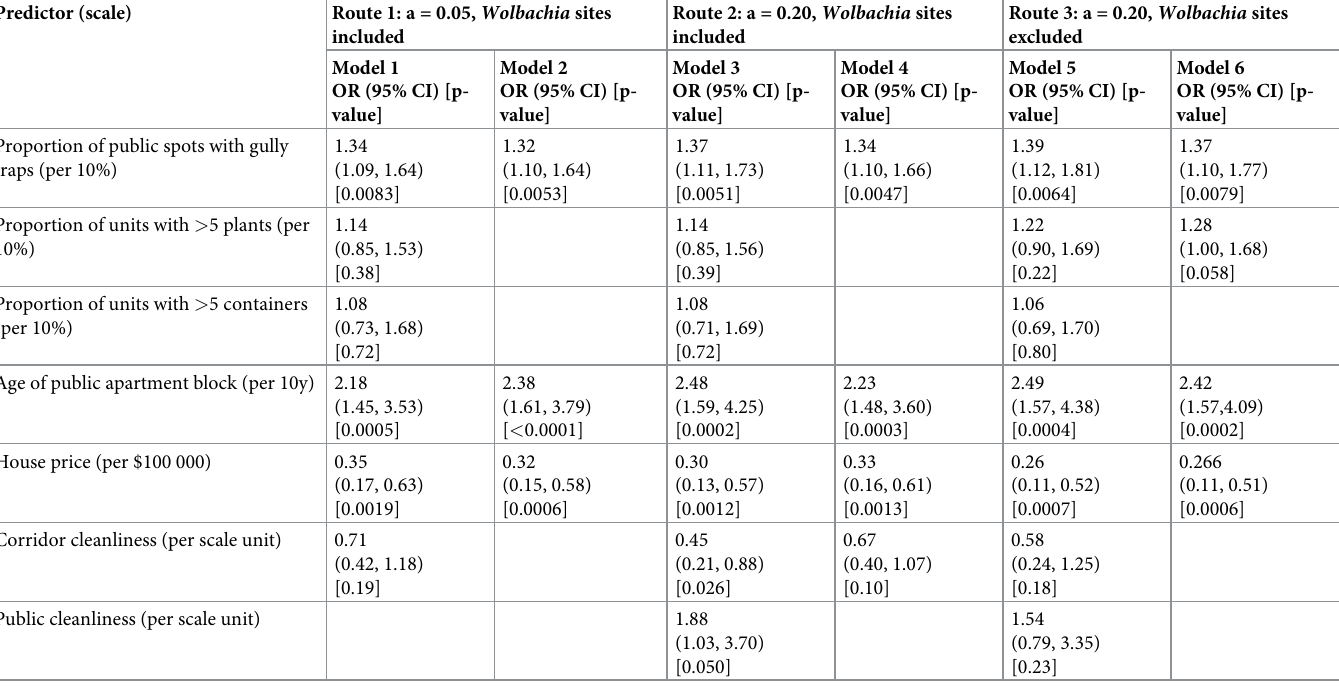
Table 3. Multivariable logistic regression modelling.